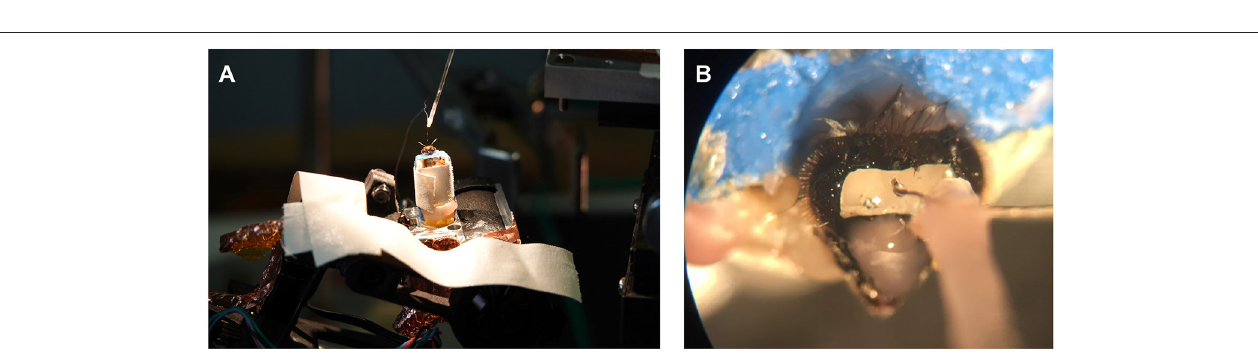
FIGURE 4 | Environment of the navigation experiments. (A) View of the onboard video camera. The frame shows the experimental environment while the copter is en route to the feeder (see marked location in B ). (B) Trajectory of the trefoil flight pattern. Flights started at the south-west corner of the field, ∼ 180 m from the hive.